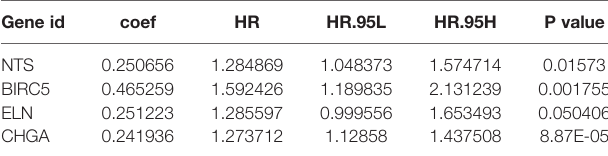
TABLE 3 | The four hub genes in multivariate Cox